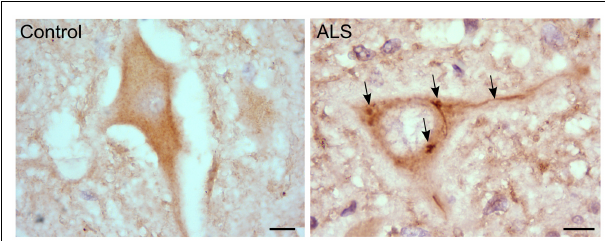
FIGURE 3 | RGNEF pathology inALS motor neurons. Representative image of RGNEF cytoplasmic inclusions observed in motor neurons of ALS patients (indicated by arrows) compared with a control case. Immunohisto- chemistry was performed as described previously (Keller etal., 2012; Droppelmann etal., 2013a) using goat polyclonal anti-RGNEF (MediMabs; 1:500 dilution; Scale bar = 10 μ m).